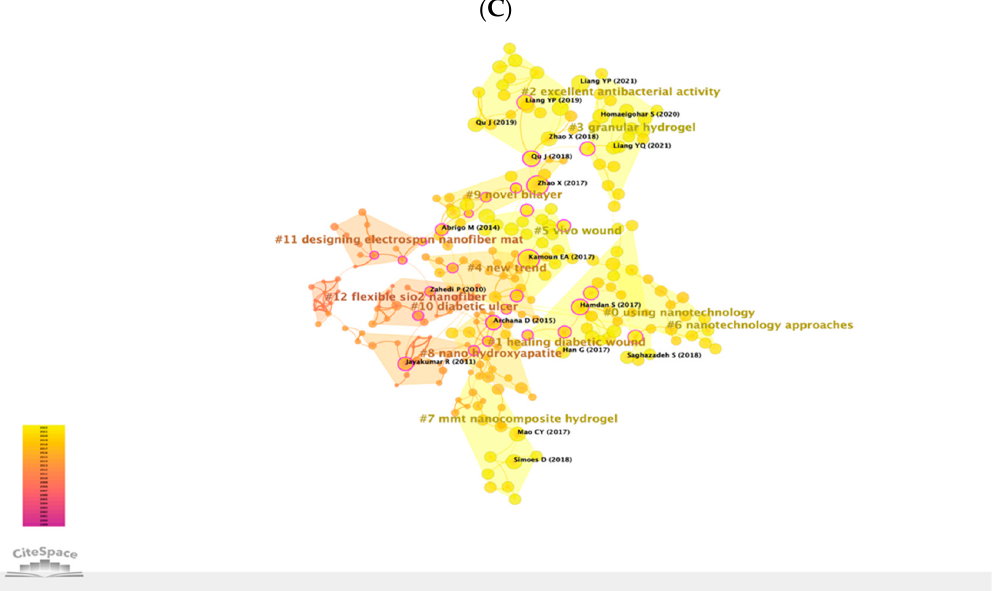
Figure 8. ( A ) The top 25 references with the strongest citation bursts in the co-citation network [10,11,19–41]. ( B ) The network map of reference co-citation for NDSRSs in the wound healing field. ( C ) The network map of reference co-citation clusters for NDSRSs in the wound healing field.